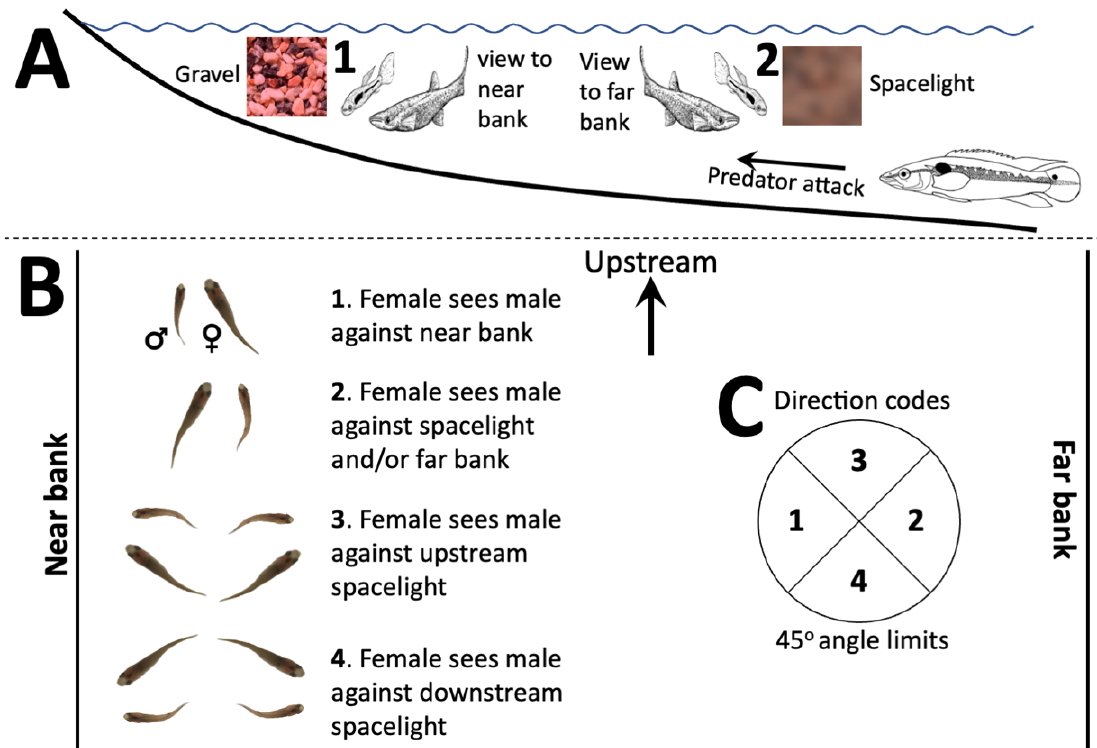
Figure 1. Guppy courtship location, orientation and orientation scoring scheme ( A ). Pairs court in the shallows and most predator attacks come from the depths. Near stream bank views tend to be gravel, rocks, dead leaves, and silt. Views in other directions consist mostly or entirely of sidewelling light (“spacelight”) ( B ). The courting pair (female larger) was scored as oriented in one of four directions relative to the near bank, relative to the female’s view of the male ( C ). A given direction code was recorded if the male’s orientation was within ± 45 ◦ of the nominal direction. Guppy drawings in ( A ) are modified from [20].